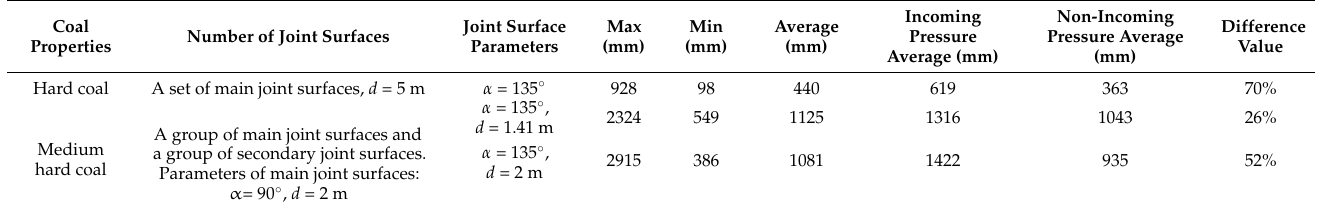
Table 10. Coal wall Y-displacement in different joint spacing ( α = 135 ◦ ).